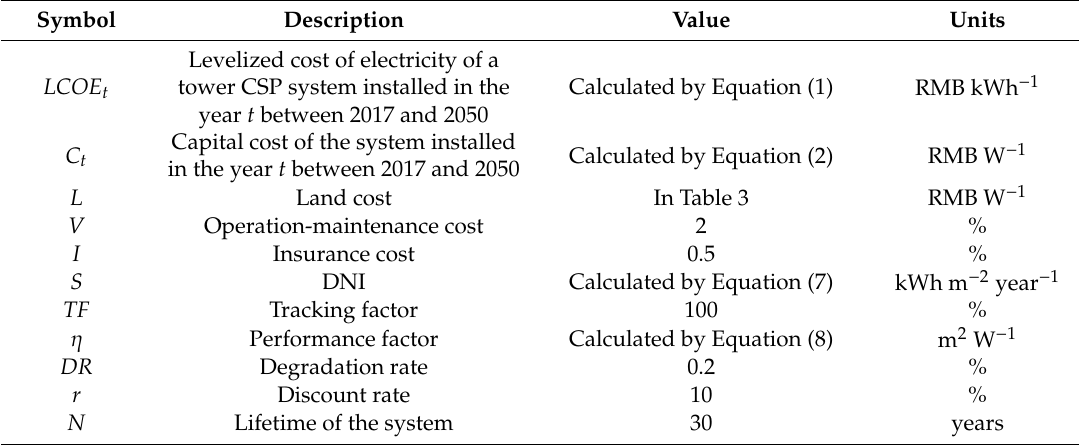
Table 1. Parameters and their values of the levelized cost of electricity (LCOE)